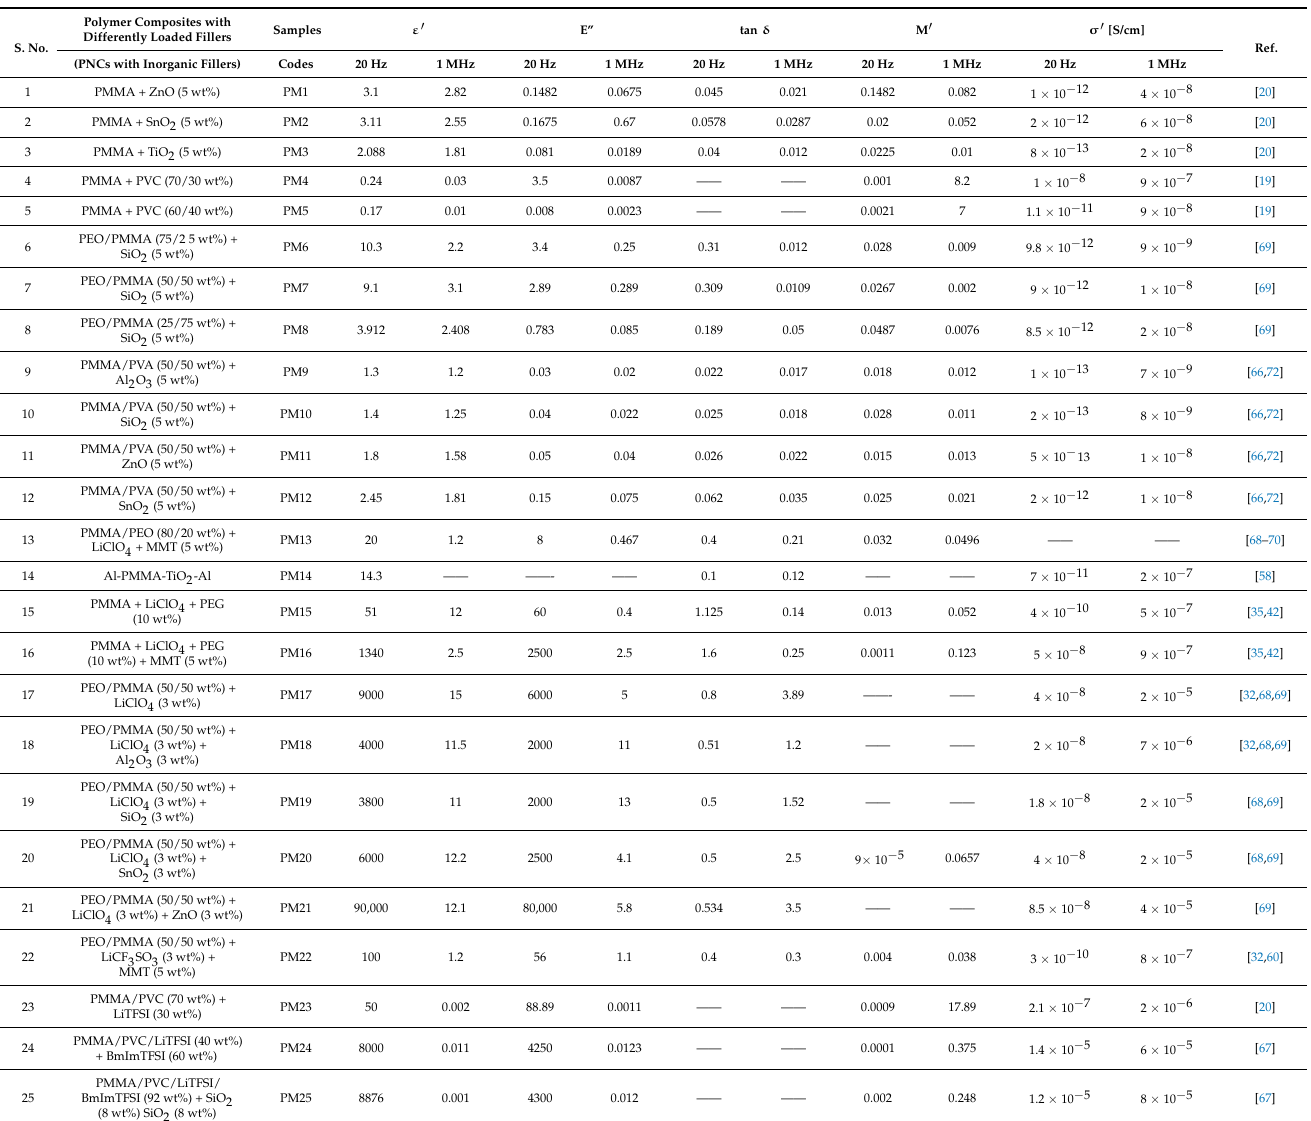
Table 1. Values of dielectric parameters ( ε (cid:48) , ε ”, tan δ , M (cid:48) and σ (cid:48) ) of different sample materials with loading